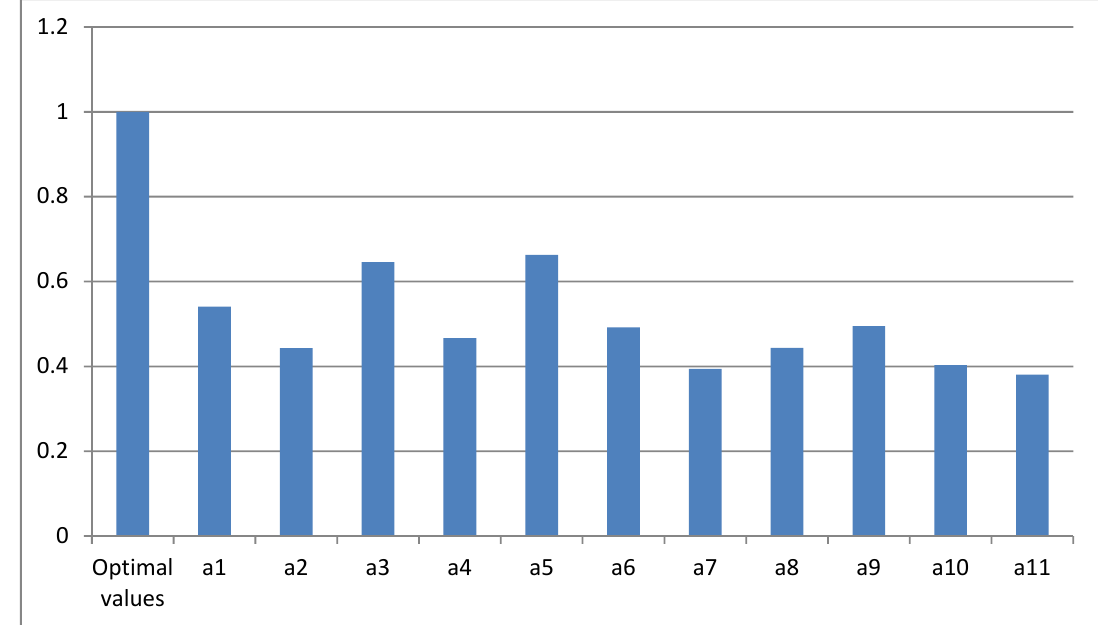
Fig. 3. The summary of the results of final